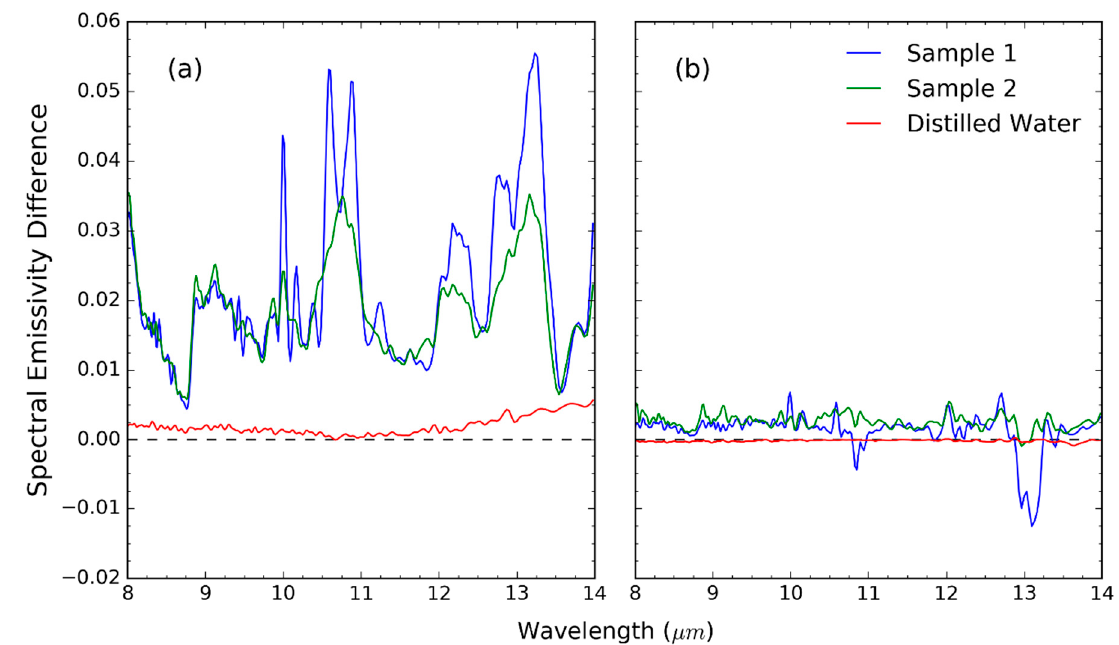
Figure 14. Differences between the surface spectral emissivities derived at KCL using the substitution method and the comparative method ( ε sub − ε comp ), shown here over 8–14 µ m for both the artificial samples and distilled water when ( a ) leaving the reflectance of the comparative reference target as specified by the manufacturer and ( b ) scaling the absolute reflectance of the comparative reference target by 0.87.